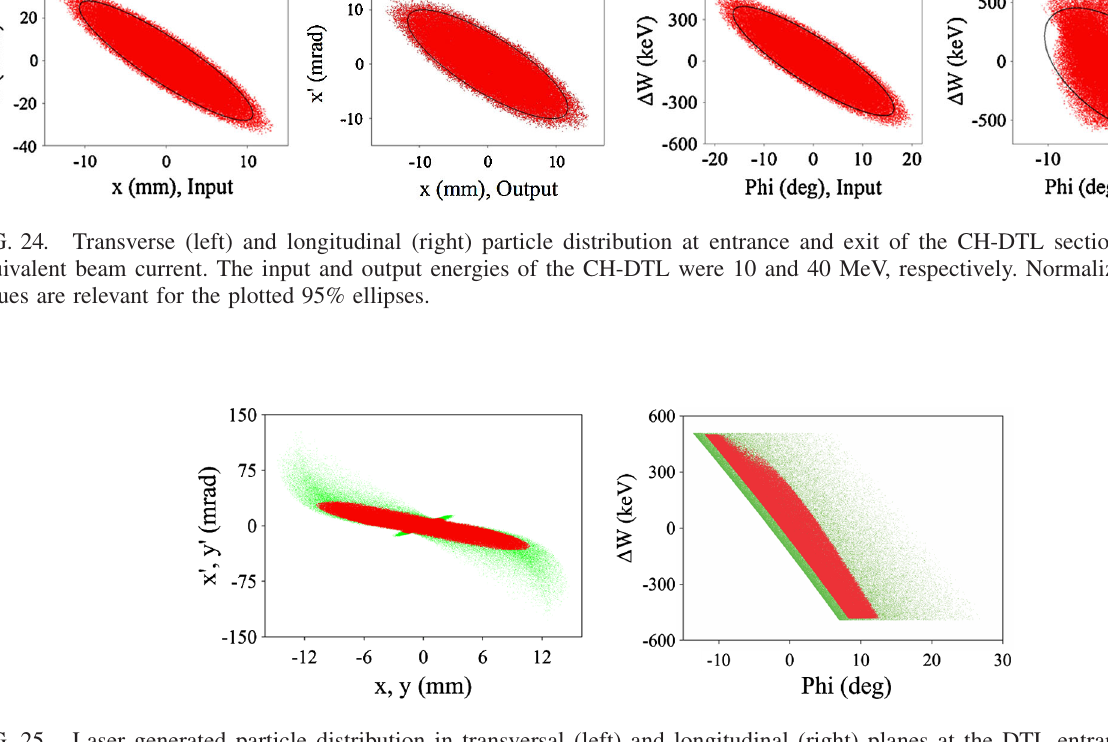
FIG. 25. Laser generated particle distribution in transversal (left) and longitudinal (right) planes at the DTL entrance within an energy range 10 MeV (cid:2) 0 : 5 MeV in green (identical with the green distribution of Fig. 17, right). The red 72% subset falls within the transverse CH-DTL acceptance area and is used for DTL beam dynamics